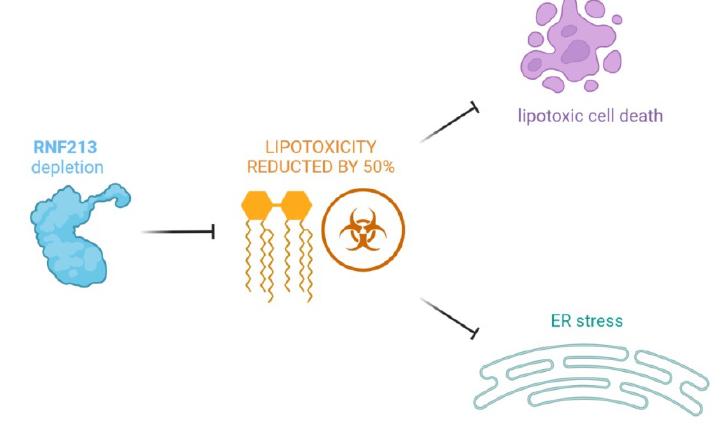
Figure 1. A protective mechanism mediated by the RNF213 protein against palmitate-induced lipotoxicity (ER, endoplasmic reticulum).